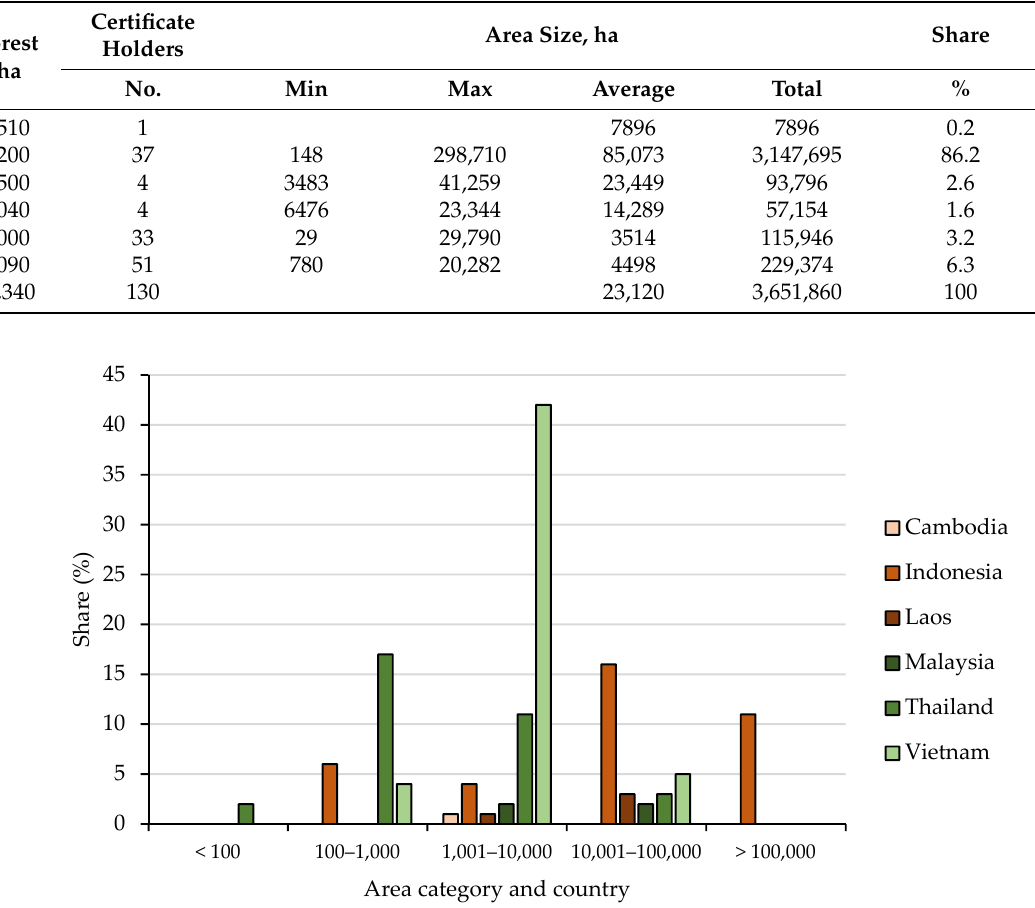
Table 3. Total size of forested [38] and FSC certified areas in SEA countries.